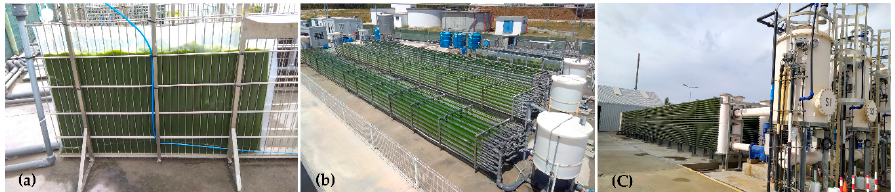
Figure 1. Different scale systems used for outdoor scale-up: ( a ) 0.25-m 3 flat panel photobioreactor (FP); ( b ) 2.5-m 3 pilot-scale tubular photobioreactor (PBR); ( c ) 10-m 3 industrial PBR. Pictures were provided